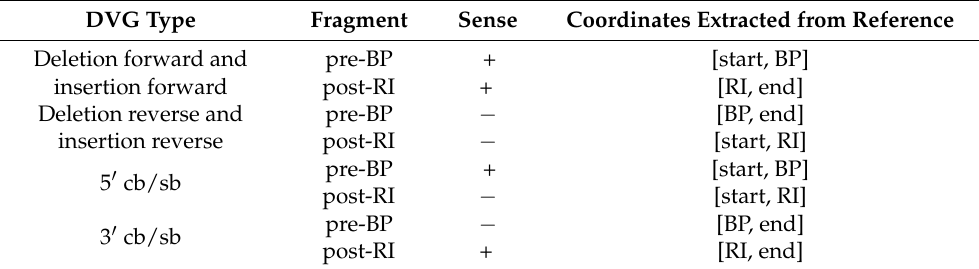
Table 2. Coordinates used for the reconstruction of the theoretical length of the DVGs in a (+)ssRNA viral genome. The length is calculated as the sum of the nucleotides that conform the pre-BP and post-RI fragments. DVG Type Fragment Sense Coordinates Extracted from Reference Deletion forward and pre-BP + insertion forward post-RI